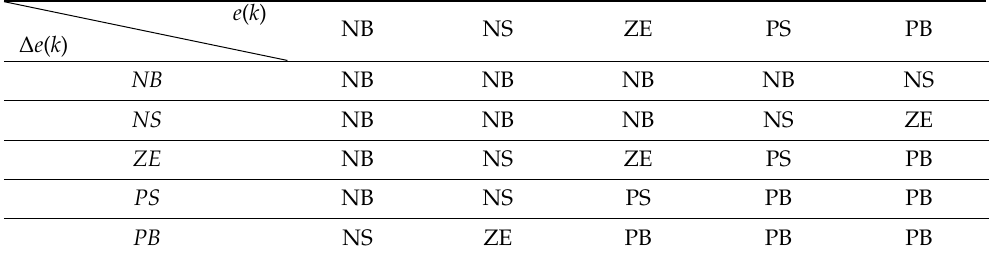
Table 3. The rule table for the traditional fuzzy controller for ∆ Q i ( i = 1, 2, 3).